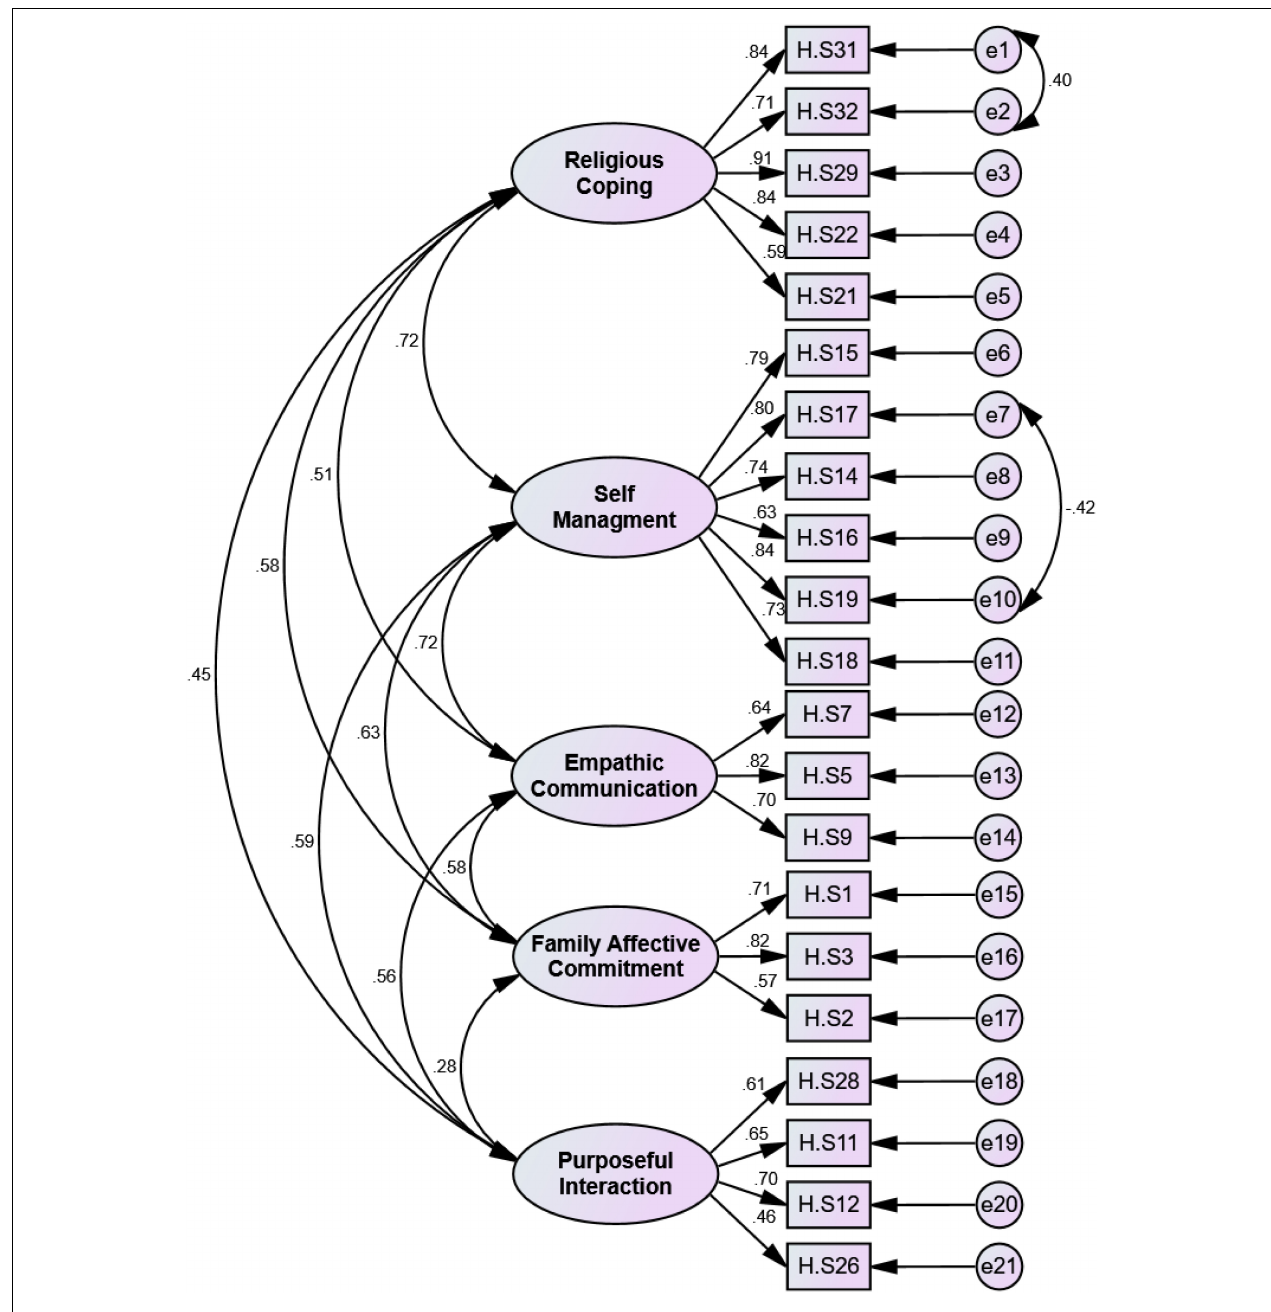
FIGURE 4 | First order CFA of family caregiver hardiness scale ( n =